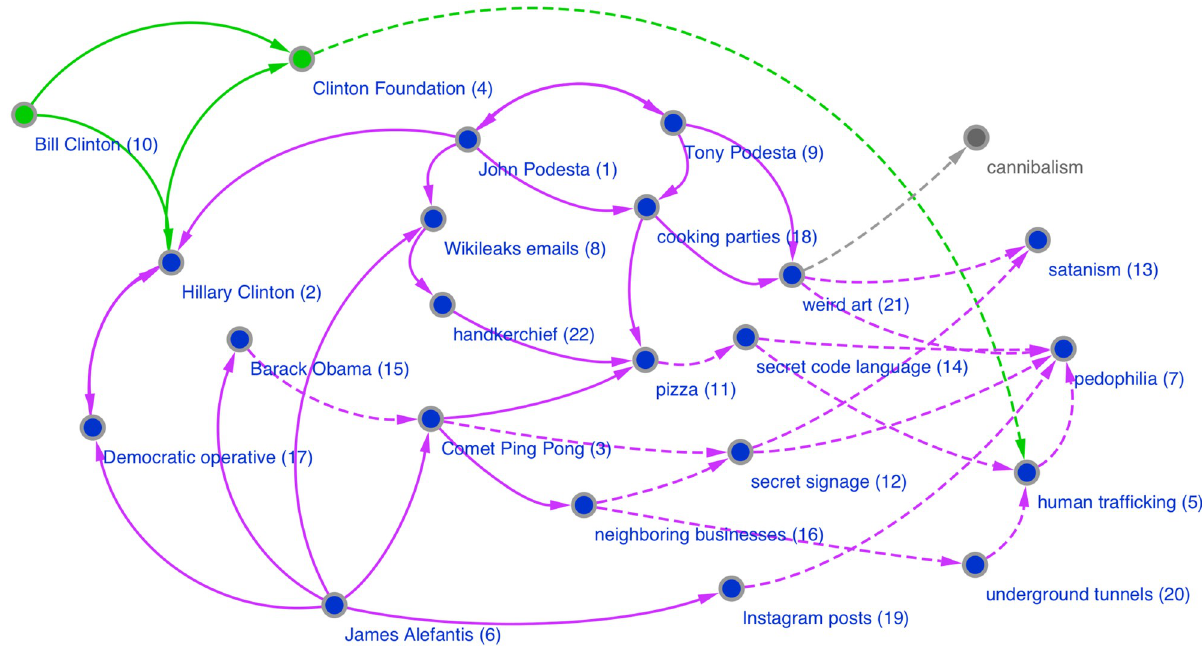
Fig 6. Comparison of our results with the NY Times Pizzagate hand-drawn graph. Edges and nodes that we do not discover in the top ranked actants through the pipeline are greyed out (cannibalism). Highly ranked edges and nodes that we discover not included in the NY Times illustration are in green (Bill Clinton and Clinton Foundation). We maintain the visual convention of dashed lines that the NY Times uses to identify relationships based on the interpretation by the conspiracy theorists of hidden knowledge. Immediately following the node label is the ranking of the actant as discovered by our